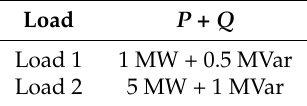
Table A4. Static Load Parameters.